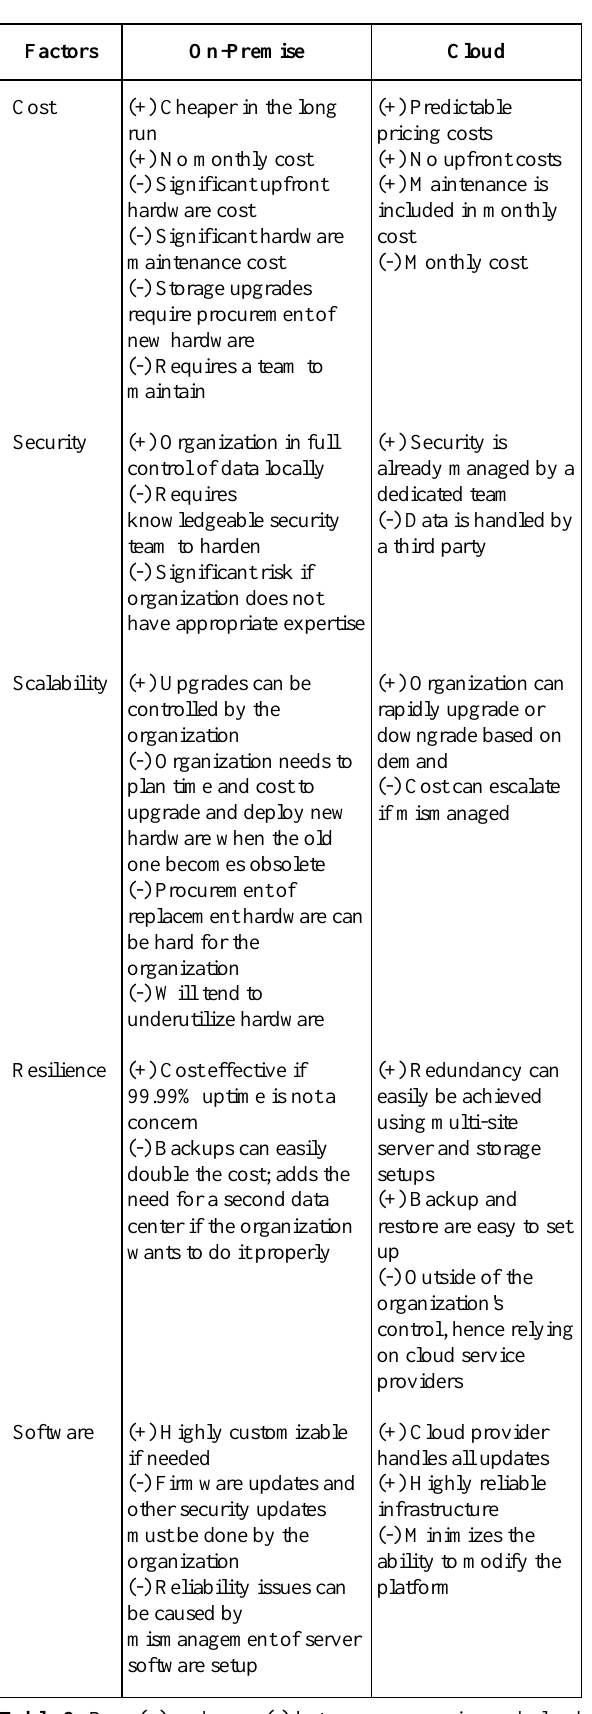
Table 3 . Pros (+) and cons (-) between on-premise and cloud systems.